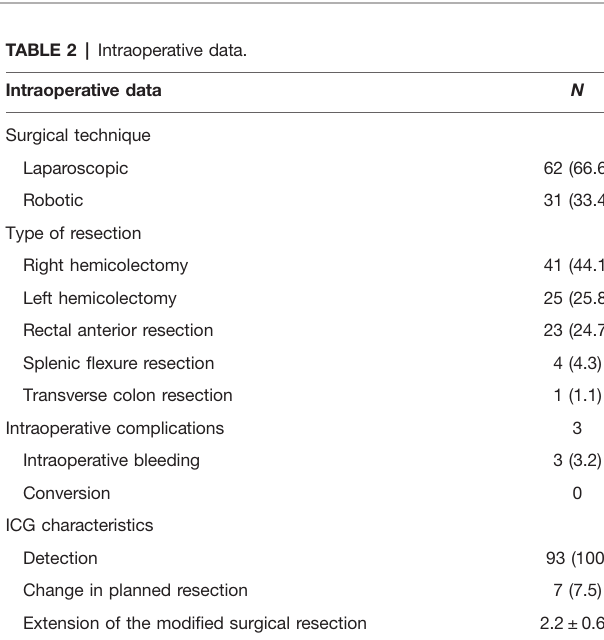
FIGURE 1 | Pre- ( A ) and post-anastomotic ( B ) application of the Indocyanine Green